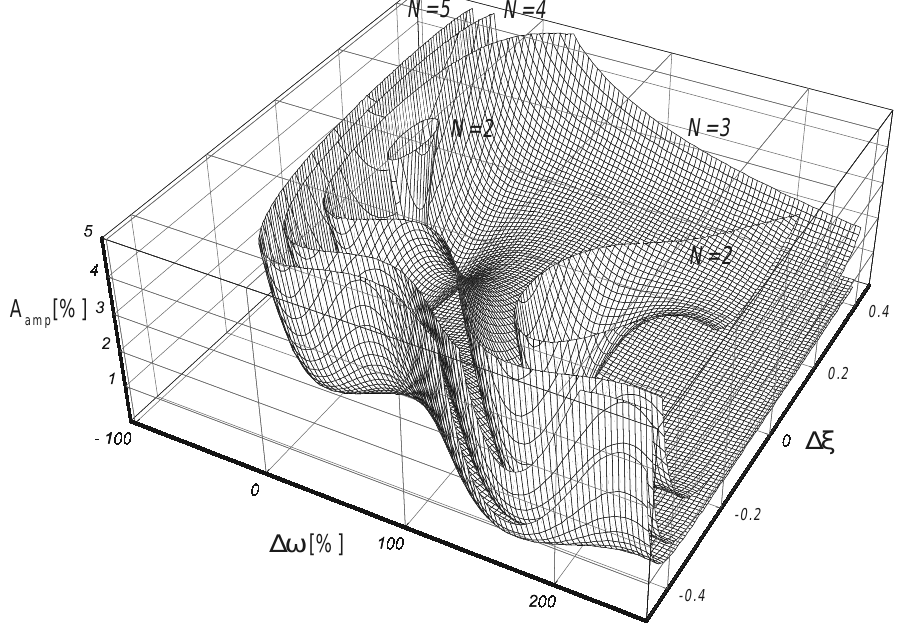
Fig. 3. Amplitude at the end of the pulse sequence with maximum overshoot A amp < 0 . 05 , high damping ratio ( ζ = 0 . 5)